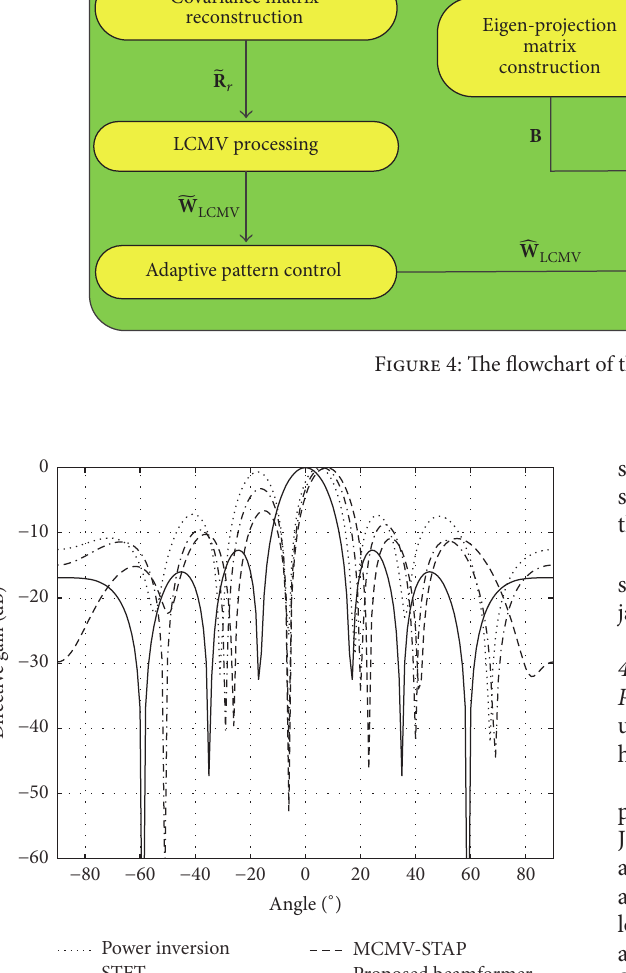
and uniform all around. The zero-mean noise is robust, random, and of no relation with expected